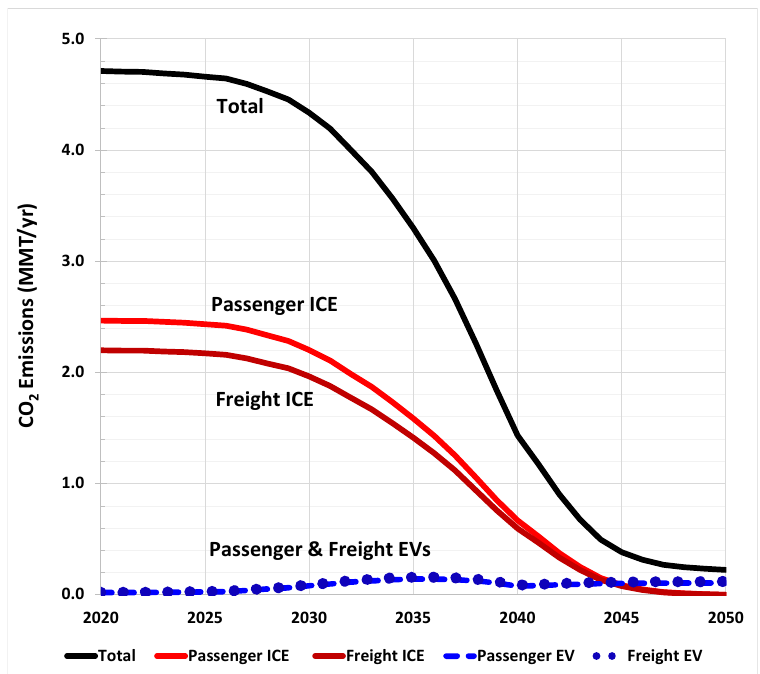
Figure 15. Total CO 2 emissions for passenger and freight vehicles powered on Oahu under the ambitious scenario in this analysis, Scenario #1, with the faster renewable power and EV projections (in million of metric tons per year, MMT/yr).